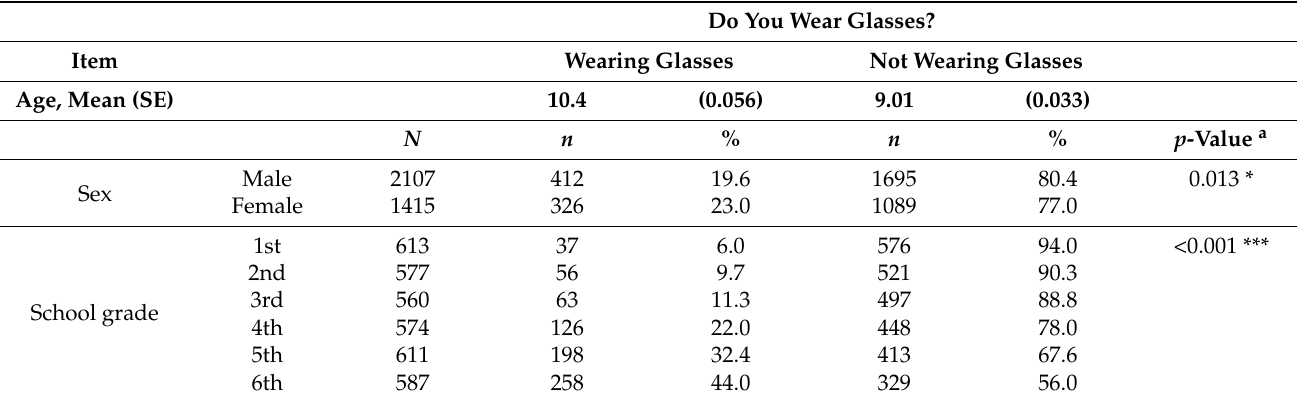
Table 2. Characteristics of elementary school students.